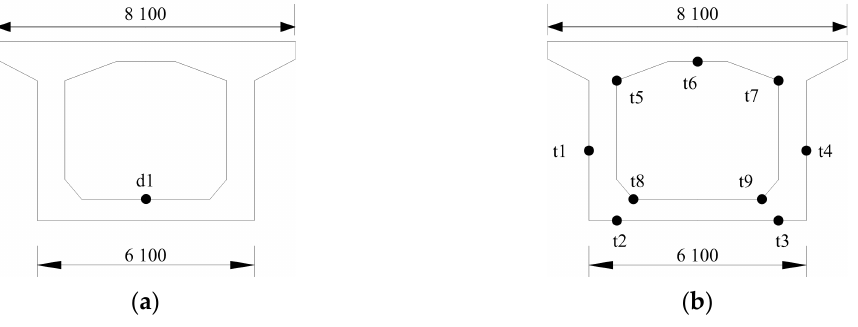
Figure 16. Cross-section layout of the bridge sensors/mm. ( a ) Deflection sensor; ( b ) temperature sensors.